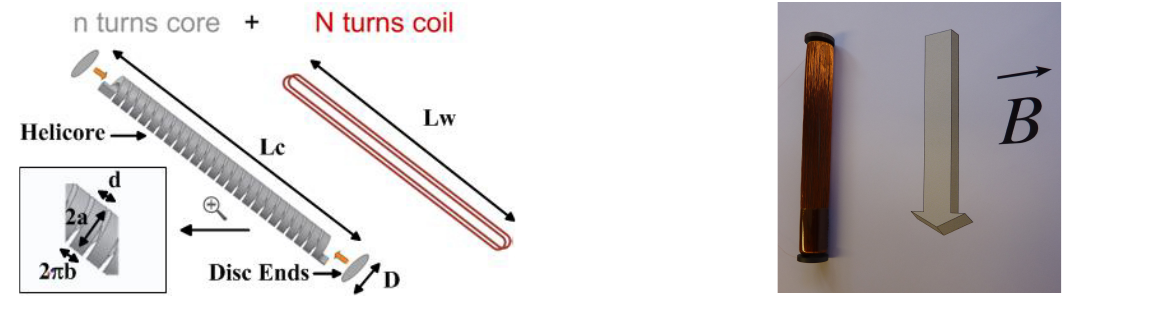
Figure 4. Diagram of the orthogonal induction sensor. Figure 5. Picture of the orthogonal induction sensor prototype.